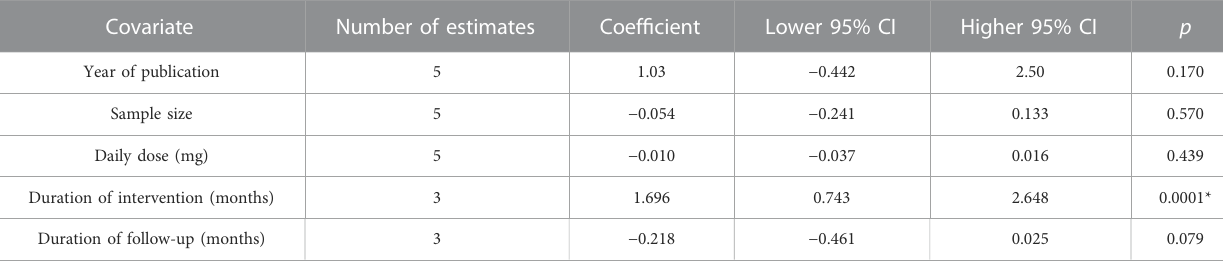
TABLE 5 Random-effect univariate meta-regression analyses of covariates on